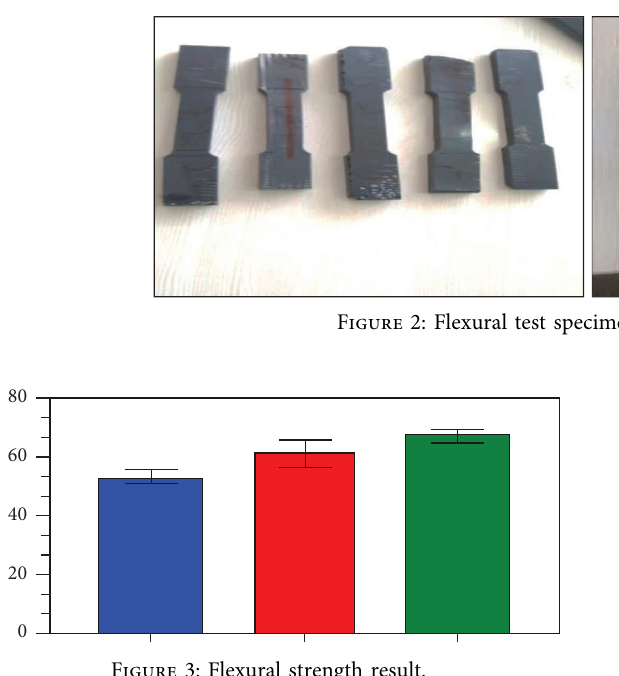
Figure 3: Flexural strength result.